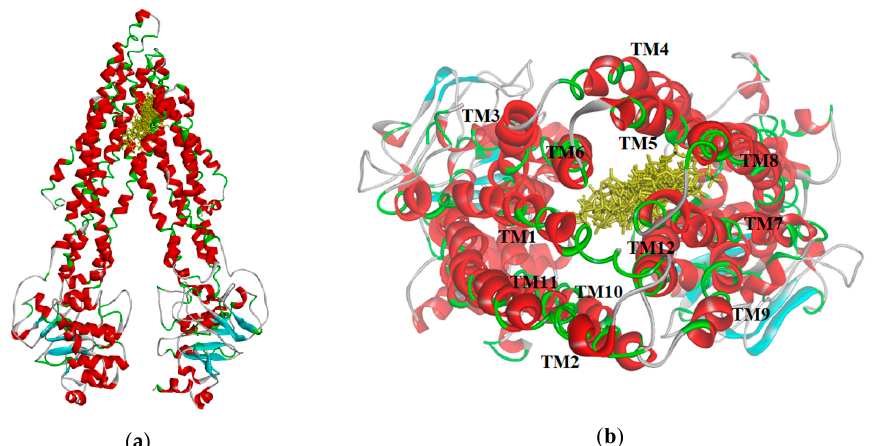
Figure 8. ( a ) Distribution of the selected ligand poses (yellow) in the homology model of h P-gp; ( b ) View from the extracellular side of the protein looking into the internal chamber. The colors representation is according to the secondary structure: helices are red, beta sheets are cyan, turns are green, and coils are white.